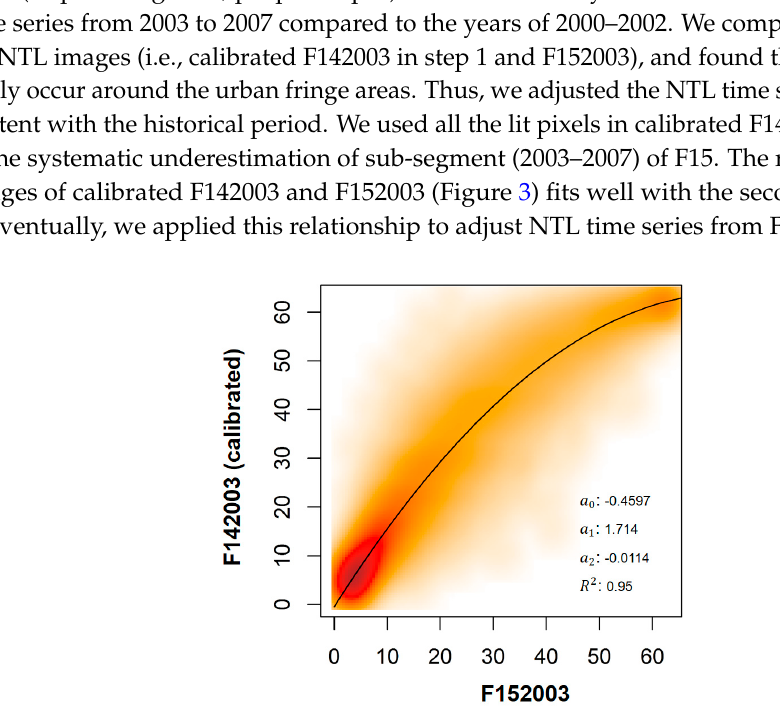
Figure 2. Relationship (and coefficients) of NTL DNs between F12 and F14 at overlaid years (1997, 1998, and 1999).